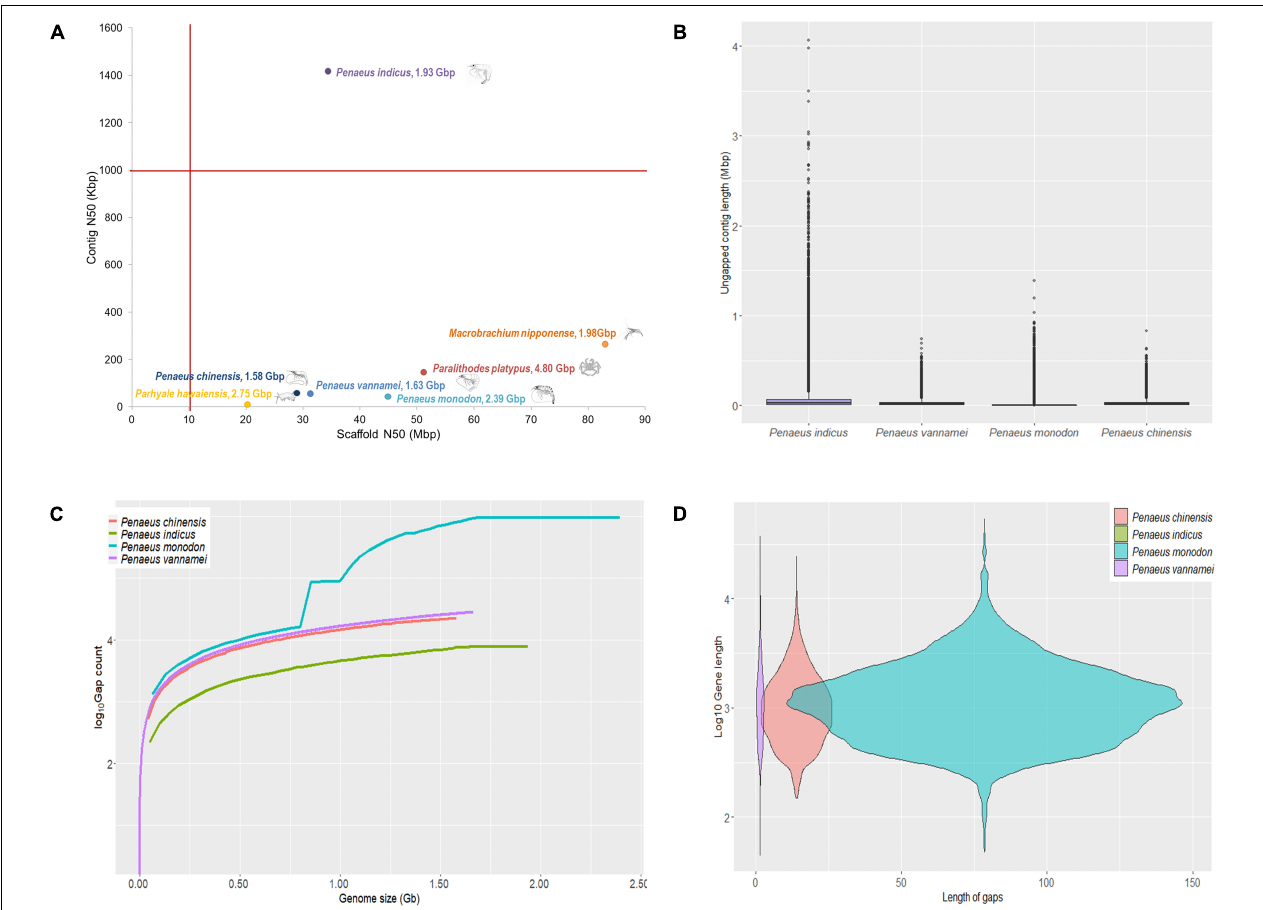
FIGURE 2 | Quality assessment of assembly generated for P. indicus in comparison to the other shrimp assemblies. (A) Plot of contig N50 and scaffold N50 lengths of finished large ( > 1.5 Gb) crustacean genomes. The P. indicus is the only large crustacean genome assembly that has > 1 Mb contig N50 and > 10 Mb scaffold N50 lengths. (B) Un-gapped contig length distribution for finished shrimp genomes. Only the genome assembly of P. indicus has contigs longer than 1 Mb length. (C) Plot of the number of gaps (log 10 scale) in the finished genomes of shrimp species. The X -axis is the cumulative genome size by counting the individual scaffold lengths in decreasing order. The Y -axis is the total number of gaps within the scaffolds contributing to the corresponding genome size. Notice that the assembly of P. indicus has less number of N’s than others. (D) Violin plot of number of N’s in gene sequences from finished genomes of shrimp plotted against the corresponding gene lengths (log 10 scale). Notice that the assembly of P. indicus has no N’s whereas the assembly of P. monodon has highest number of N’s in gene sequences.